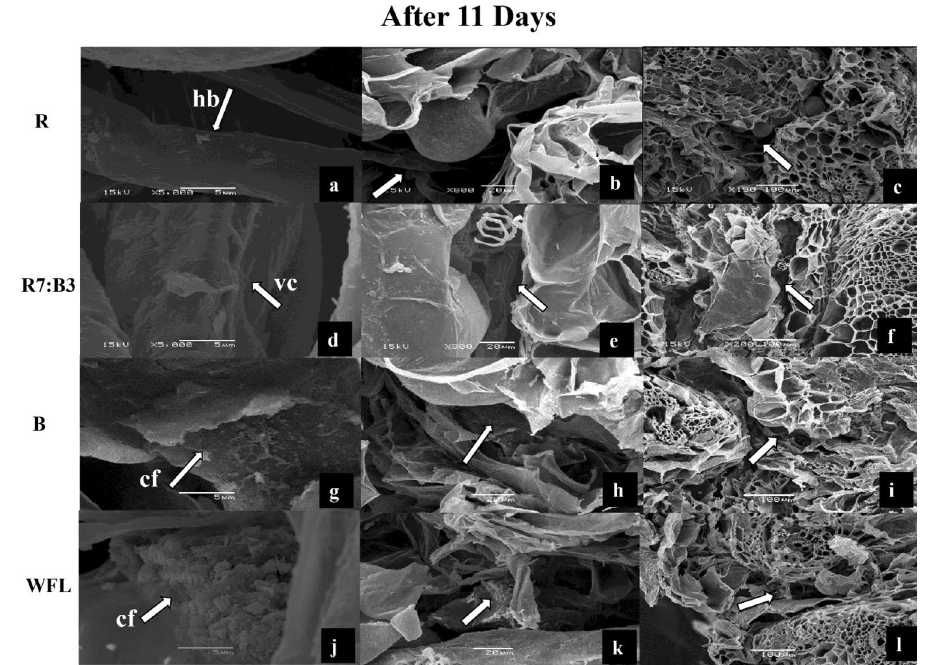
Figure 5. SEM images of interconnections between rootstock and scion after 11 days under R light ( a – c ), R7:B3 light ( d – f ), B light ( g – i ), and WFL light ( j – l ) light at 11th days after grafting. hb—horizontal bridge; cf— formation of callus tissue; vc—vascular connections.